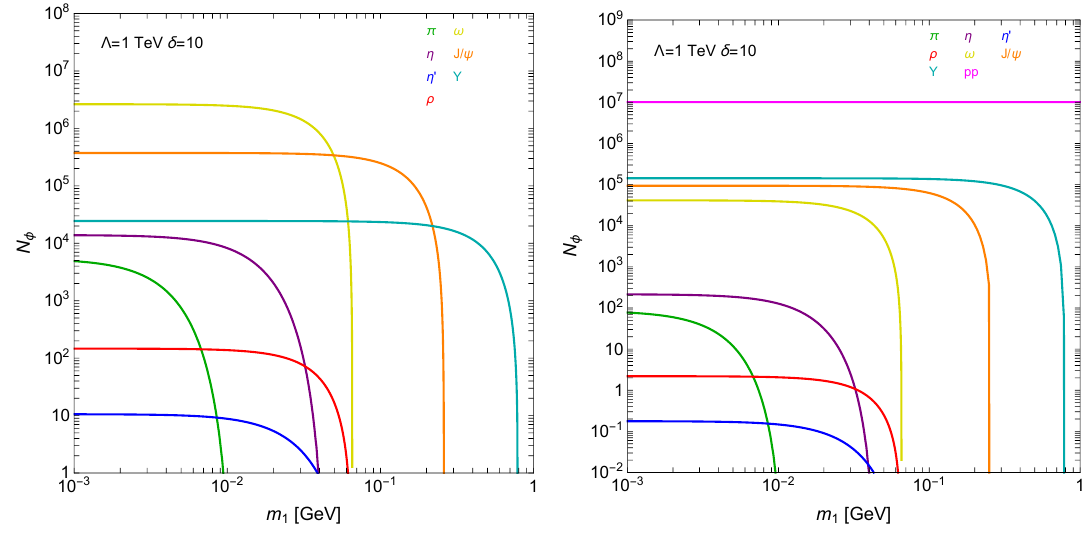
Figure 2 . Number of φ 2 particles produced in proton collisions in two different experiments: SHiP (left panel) and MATHUSLA (right panel). In the case of SHiP we consider only the production via mesons decays. For MATHUSLA we include also direct parton production (pp). In both panels we fix c f = c f = 1 , δ = 10 and Λ = 1 L R